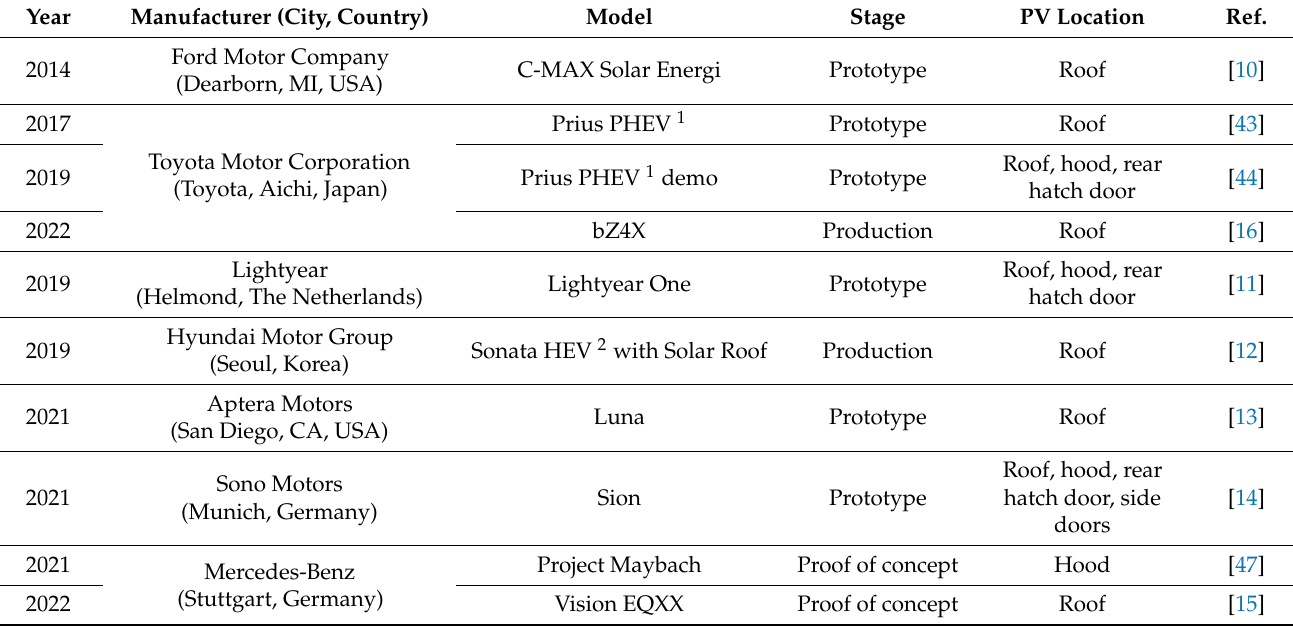
Table A1. Summary of released solar-powered electric vehicles.